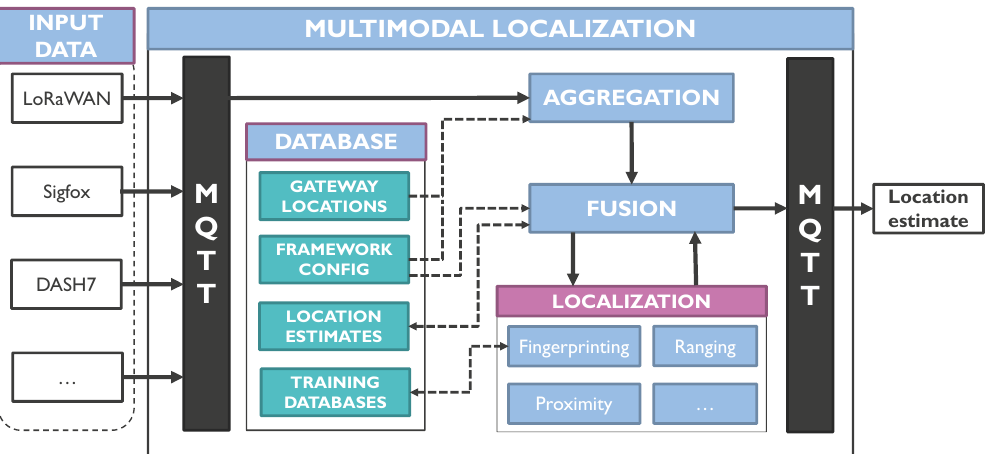
Figure 2. This figure provides a concise overview of our multimodal localization framework, which can be used together with our VNO.